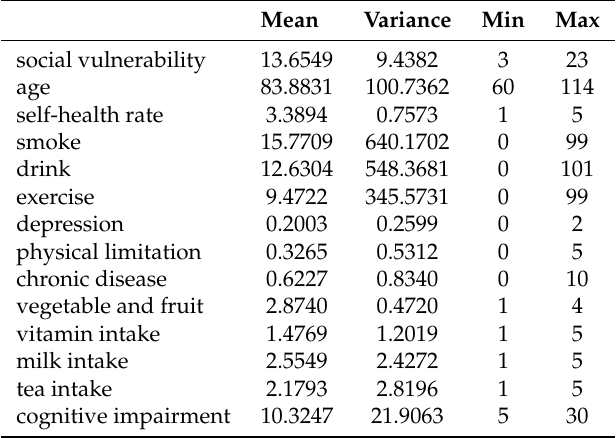
Table 2. Descriptive Statistics ( N =